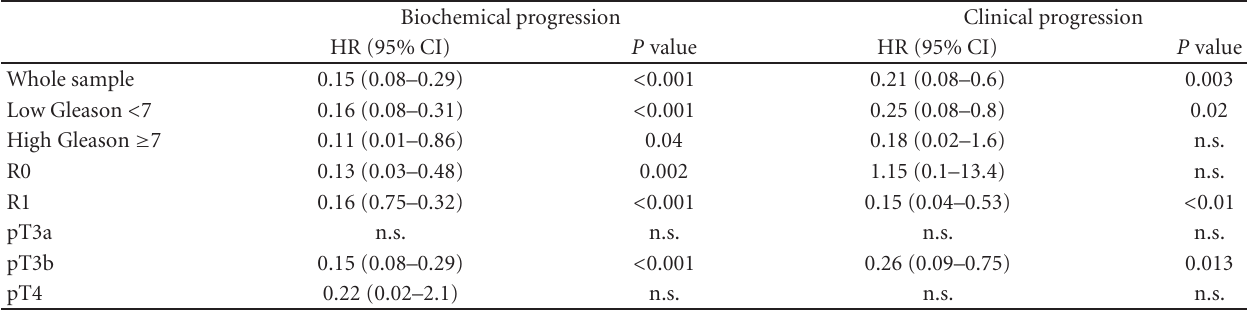
Table 3: Univariable cox regression models for comparing groups 1 and 2; endpoint: biochemical recurrence and clinical progression. (For clinical progression follow-up data were available for 132